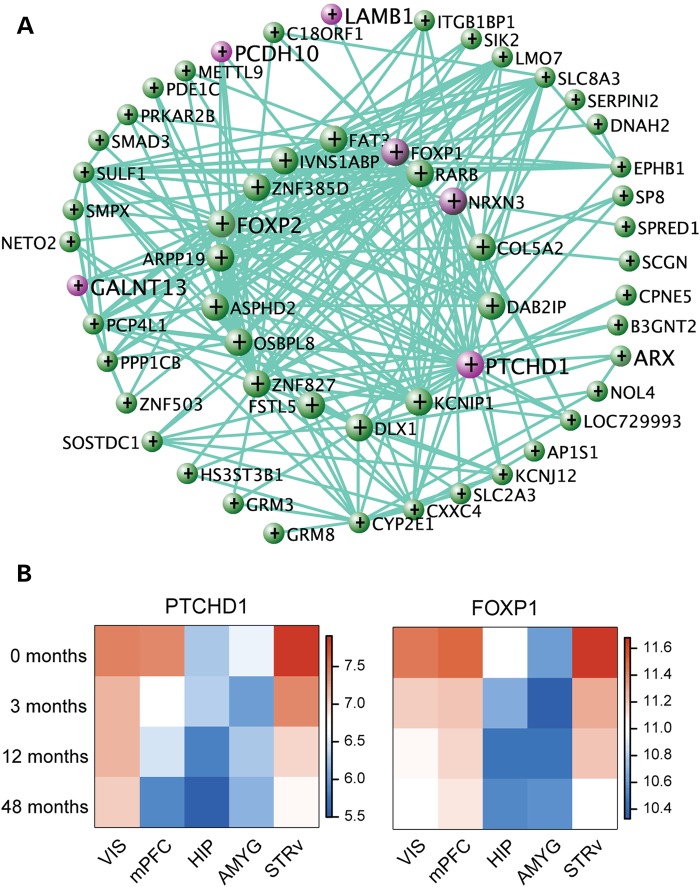
Module M12 is associated with ASD candidate genes. (A) VisANT plot showing the top 200 connections in M12. The hub genes, which have more connections, are displayed in the inner circle. Purple nodes indicate genes identified as ASD candidate genes from SFARI Base, with the remaining nodes shown in green. (B) Heatmap of the expression patterns for two hub genes in module M12. Cell colors show the average expression of samples from the specified age (y-axis) and region (x-axis).